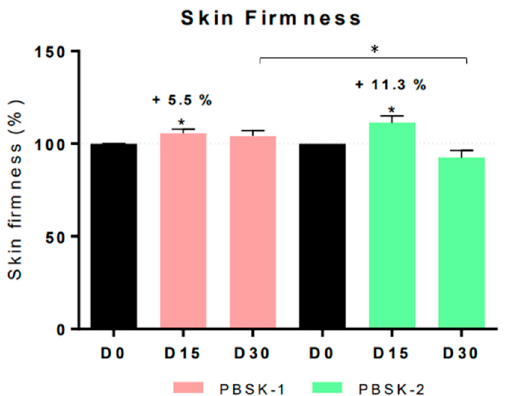
Figure 14. Graphical representation of skin firmness quantified in the skin through Cutometer ® , before (D 0 ), after 15 days of treatment (D 15 ) and after 30 days of treatment (D 30 ), with mask PBSK-1 or mask PBSK-2, in 30 human volunteers, comparing each volunteer with its own control at day 0 and PBSK-1 with PBSK-2 at the same day. Statistical significances: * p < 0.05 .